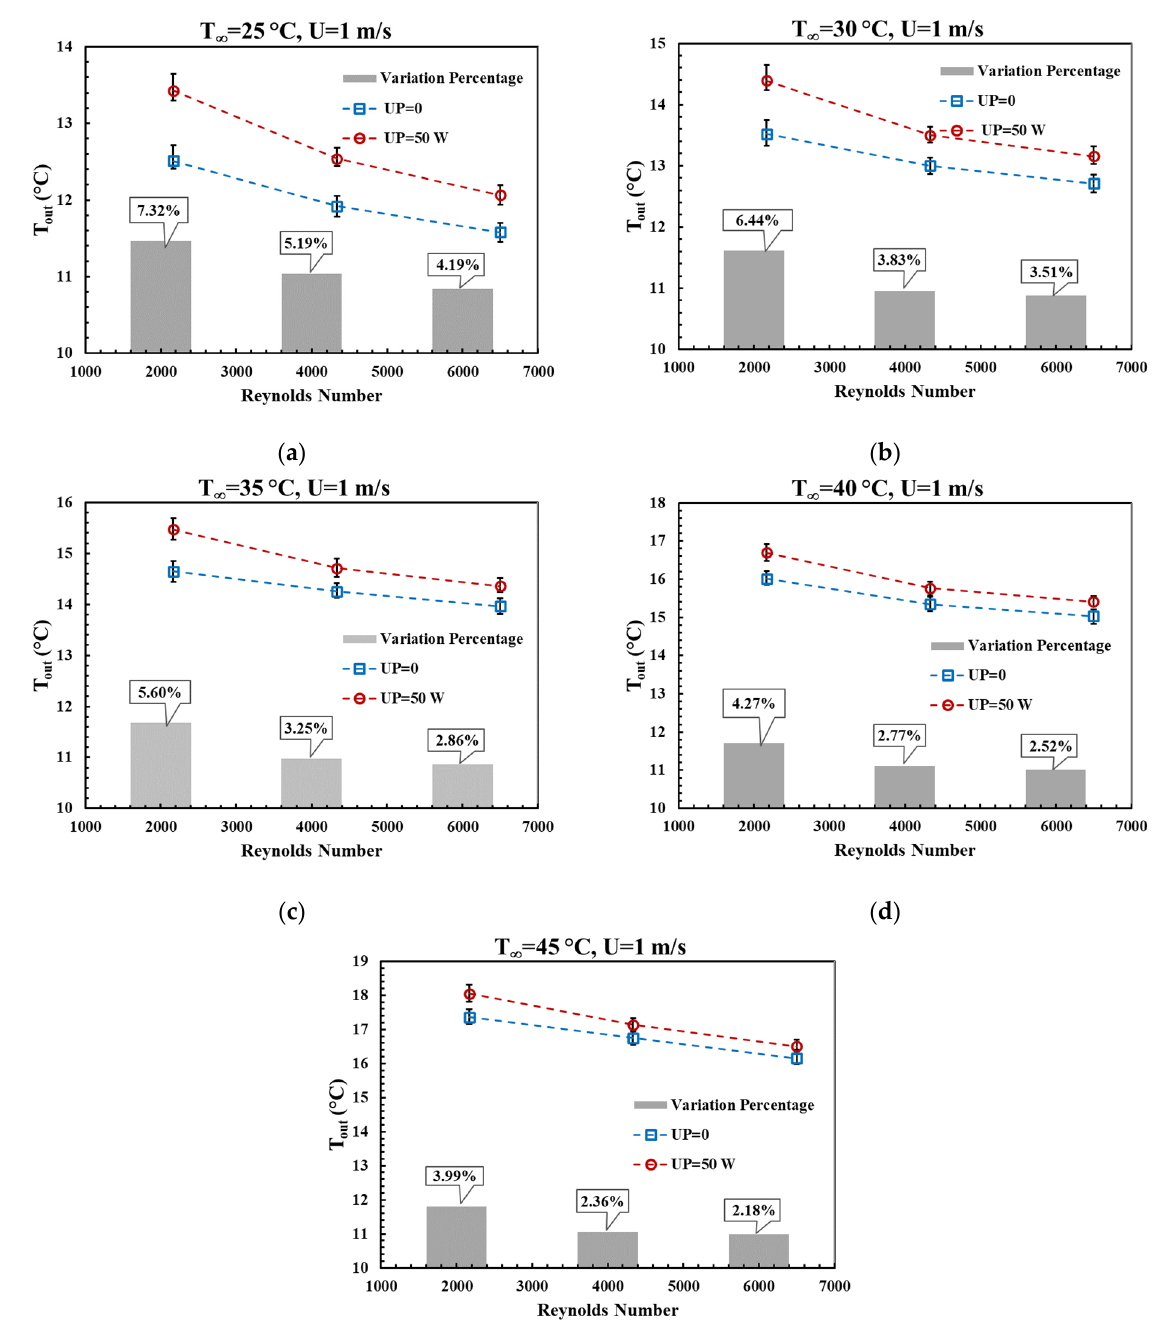
) and ( a ) 𝑻 (cid:2998) = 𝟐𝟓 (°𝐂), ( b ) ) and ( a ) T ∞ = 25 ( ◦ C), 𝒔 s